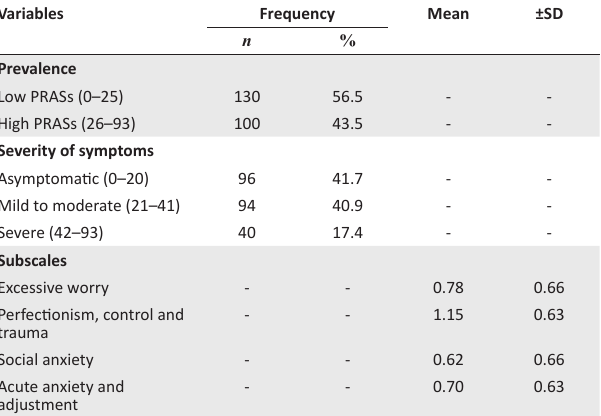
TABLE 1: Prevalence, severity and subscales of pregnancy-related anxiety symptoms. Variables